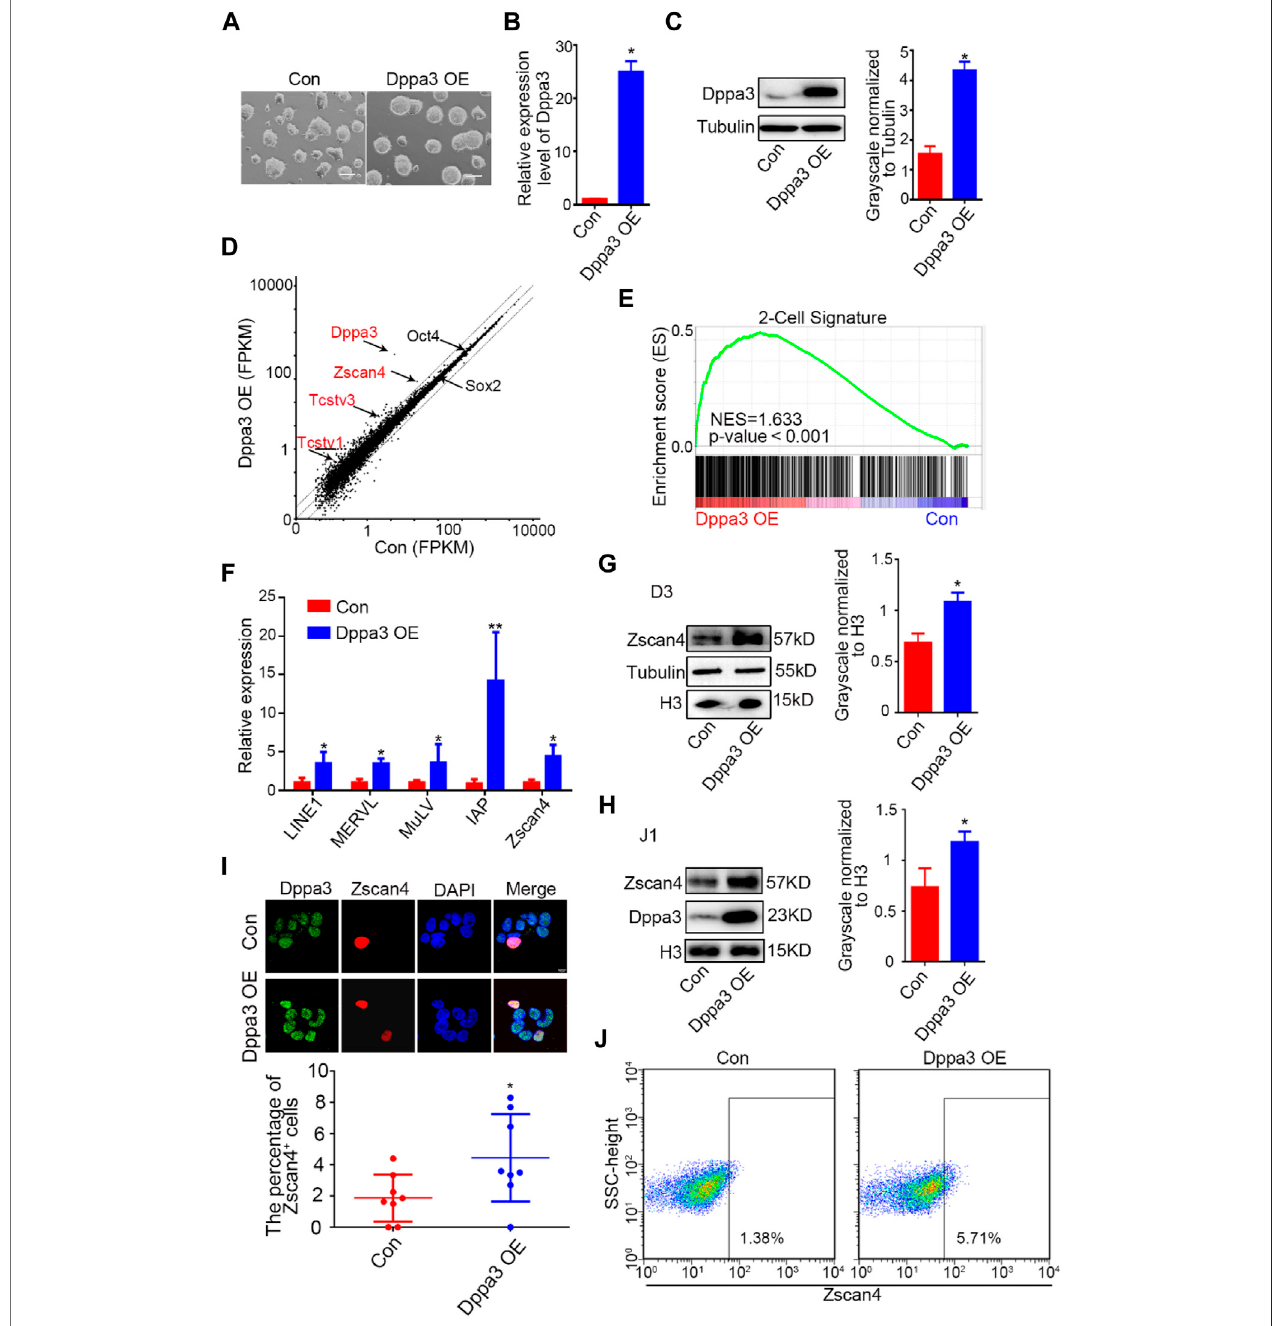
FIGURE 1 | Overexpression of Dppa3 activates a 2C-like gene expression. (A) Morphology of ESCs with an ectopic expression of Dppa3 . Scale bars represent 100 μ m. (B) Relativeexpressionlevelof Dppa3 in Dppa3 OEandcontrol(Con)ESCs. (C) WesternblotanalysisofDppa3proteinlevelin Dppa3 OEandConESCs.Right: Quanti fi cation of relative Dppa3 protein levels normalized to Tubulin by ImageJ software ( n = 3; * p < 0.05). (D) Scatter plot showing differentially expressed genes following the ectopic expression of Dppa3 in ESCs. Representative 2C genes that are upregulated in Dppa3 OE ESCs are marked in red. Two-tailed Student ’ s t -tests were used to derive the p values. (E) GSEA indicating that upregulated genes in Dppa3 OE ESCs were highly enriched in the two-cell embryo gene set. (F) qRT- PCR analysis of selected 2C-speci fi c genes and retroviral elements expression in transient Dppa3 OE ESCs. Data are presented as mean ± SEM (n = 3, * p < 0.05; ** p < 0.01). (G,H) Western blot analysis of Zscan4 protein level in stable Dppa3 overexpressed D3 (G) and J1 (H) ES cell lines. Right: Quanti fi cation of relative Zscan4 protein levels normalized toH3byImageJsoftware ( n = 3;* p < 0.05). (I) Dppa3 overexpressionincreasesZscan4 positive cells byimmuno fl uorescence stainingofZscan4(red) and Dppa3 (green) in stable Dppa3 overexpressed D3 ESCs. Scale bar represents 10 μ m. Below: Quanti fi cation of Zscan4 positive cells in Dppa3 OE and control (Con) ESCs (n = 4; * p < 0.05; each dot corresponds to one replicate experiment, in which 200 cells were counted). (J) FACS pro fi les of Zscan4 + ESCs population in stable Dppa3 OE ESCs.